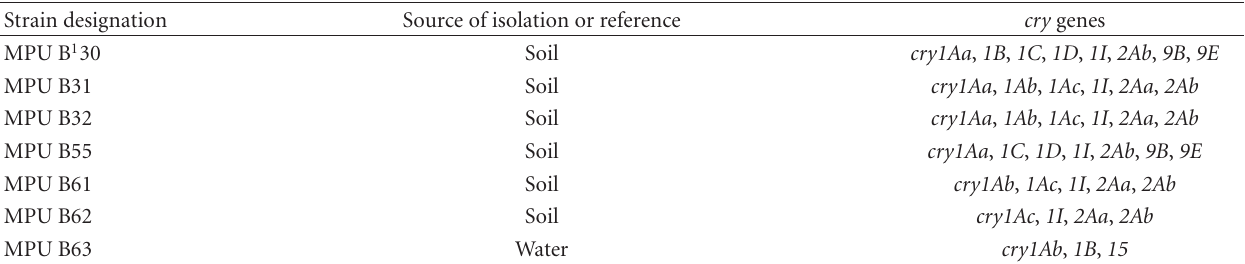
Table 1: Genes of Cry toxins in B. thuringiensis isolates cultured from samples of soil and